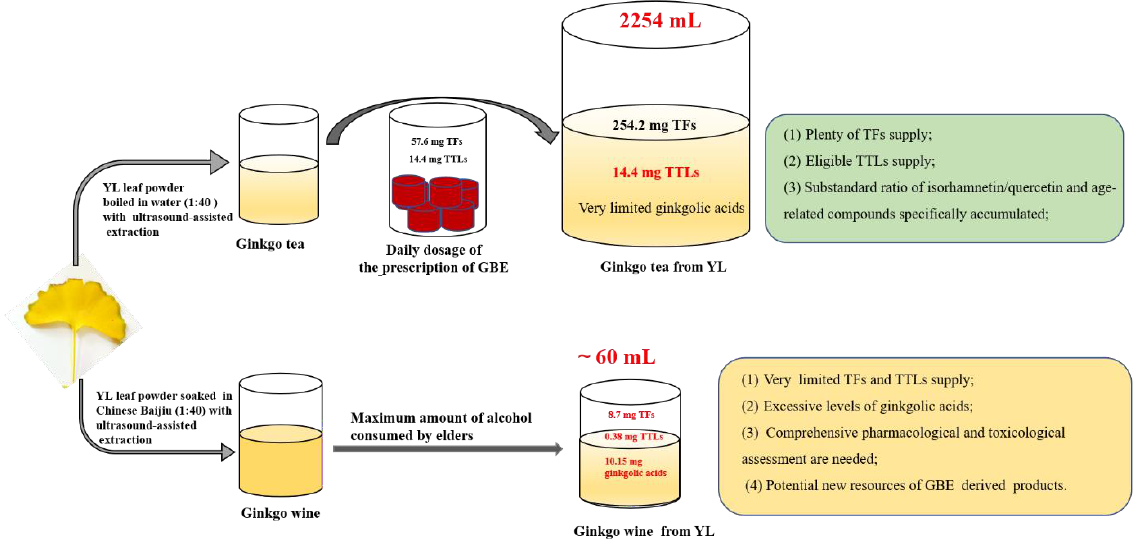
Figure 7. Summary of ingredient composition of the ginkgo tea and ginkgo wine compared with the ADI (acceptable daily intake) of prescription drugs “Yinxingye Pian” (with an SFDA approval number Z20053912). The ADIs of ginkgo flavonol glycosides (TFs) and terpene trilactones (TTLs) for disease treatment are stipulated as 57.6 mg and 14.4 mg according to the drug instructions, respectively. In our study, YL powder was infused with a solid-to-liquid ratio of 1:40. Then, 2254 mL of the first tea infusion contained 254.2 mg of TFs and 14.4 mg of TTLs. In addition, about 60 mL of the first ginkgo wine infusion contained 8.7 mg of TFs, 0.38 mg of TTLs, 10.15 mg of ginkgolic acids and plentiful biflavones.